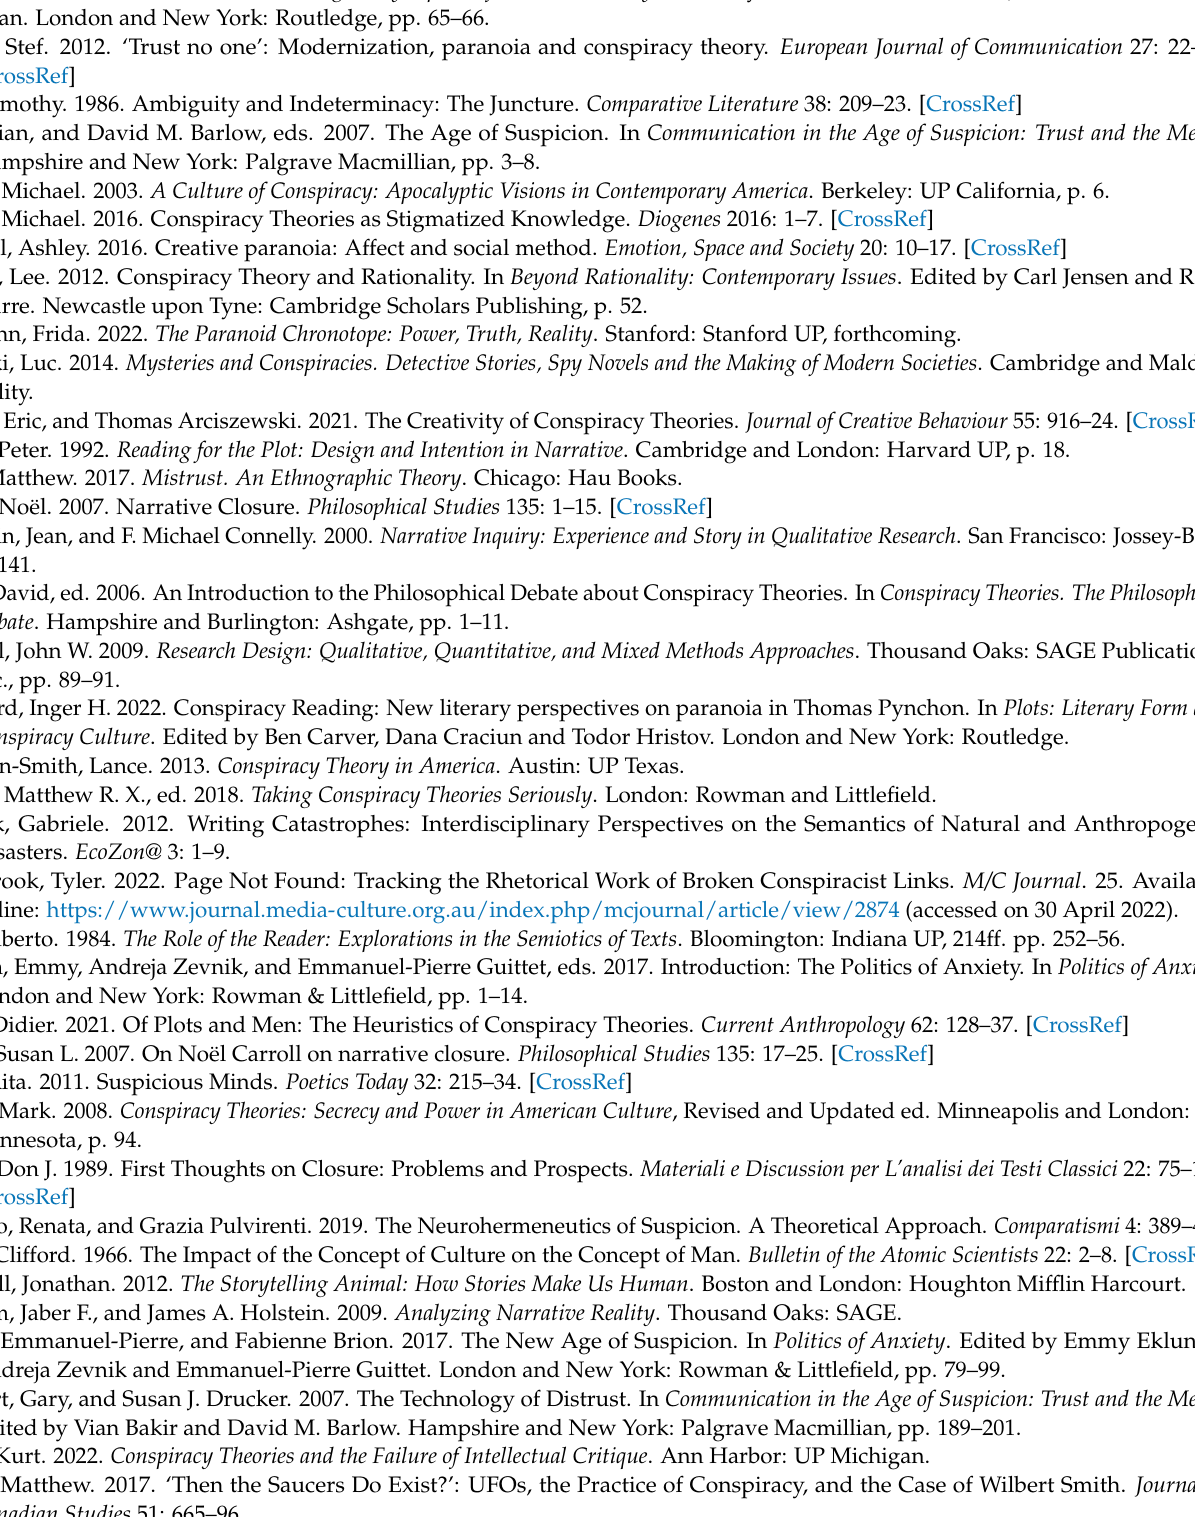
and hence, sinking of the